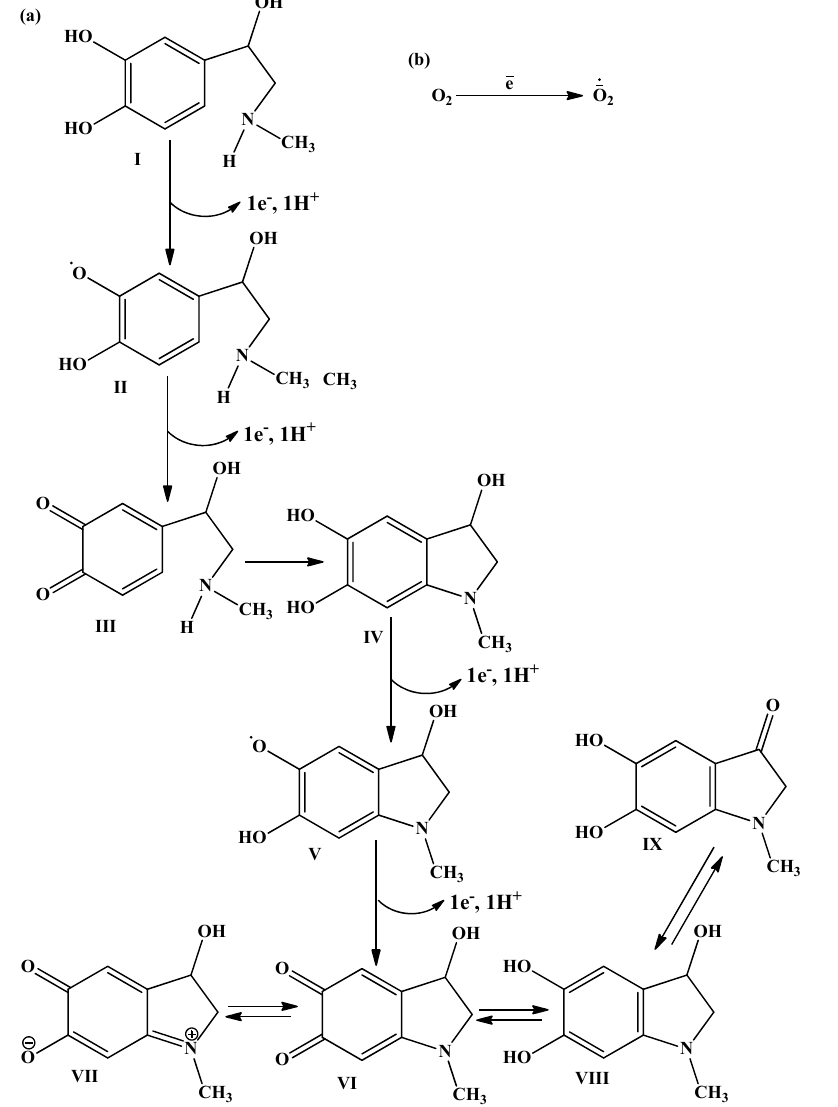
Scheme 1. The quinoid mechanism of adrenaline autoxidation. ( a ) Transformation of adrenaline I into adrenochrome VI ; II – V are intermediate reaction products; possible mutual transitions of the products varying from VI (adrenochrome) to VII , VIII , and IX ; ( b ) reaction of superoxide anion- radial formation.